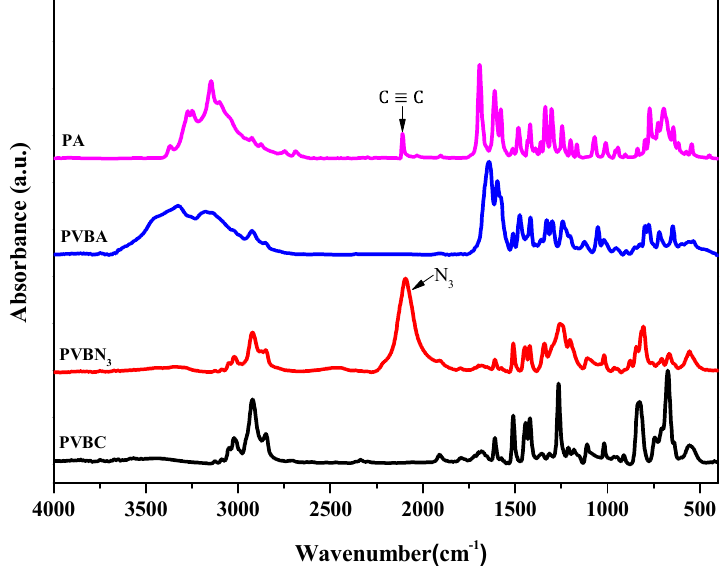
; ( c ) PVBA; and ( d ) PA in CDCl 3